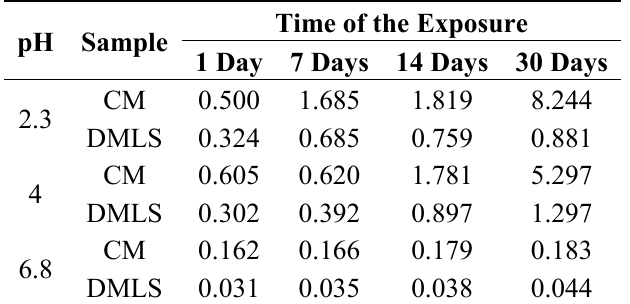
saliva of pH = 2.3, pH = 4 and pH = 6.8.